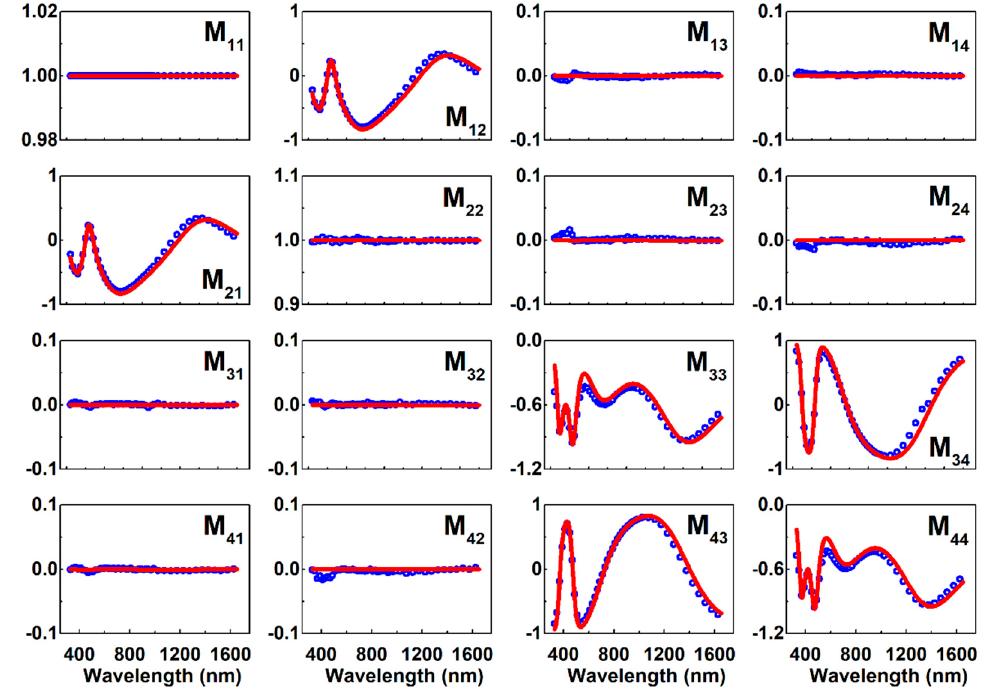
Figure 4. Measured (blue dots) and simulated (red lines) Mueller matrix elements normalized by the M 11 for the YF 3 sample prepared at a deposition angle α = 82° in the wavelength range of 300 − 1650 nm. The measurements were performed at a light incident angle θ = 65° and an azimuth orientation ϕ =